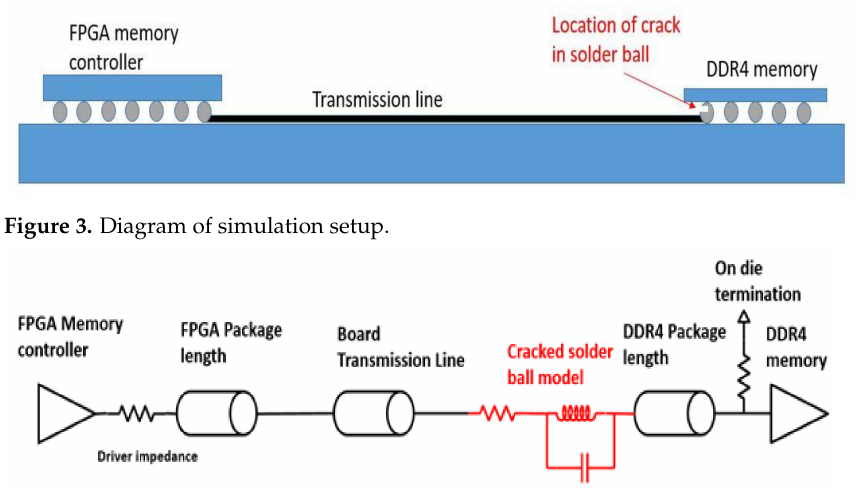
Figure 4. DDR4 data channel containing the cracked solder ball.